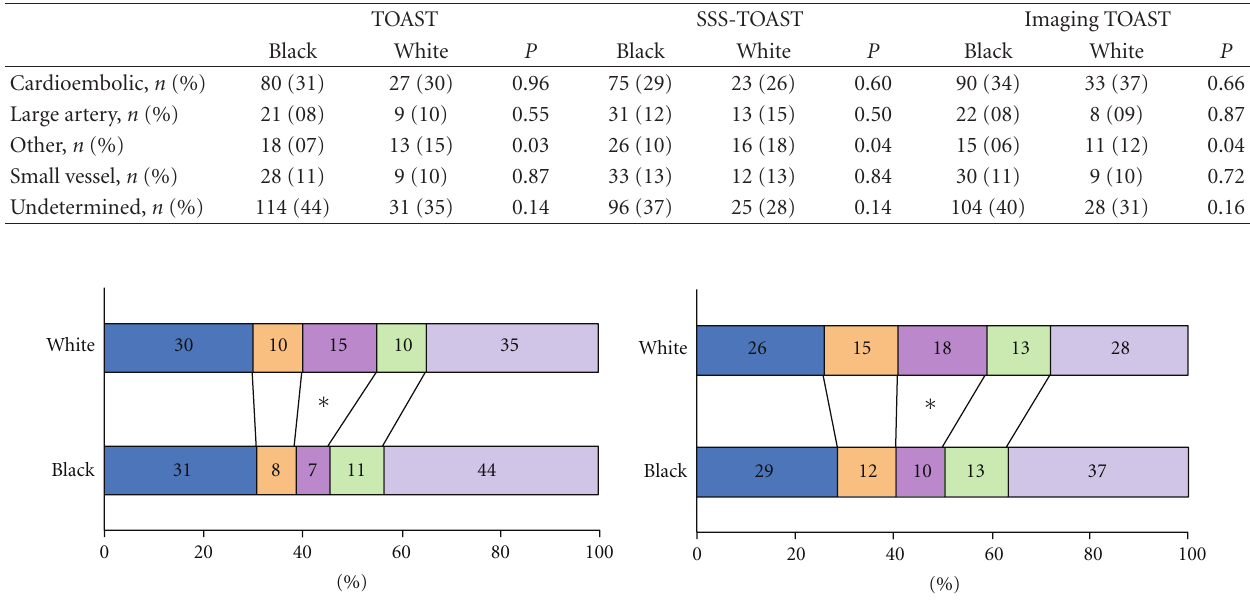
Table 2: TOAST classifications of ischemic stroke subtypes by race.